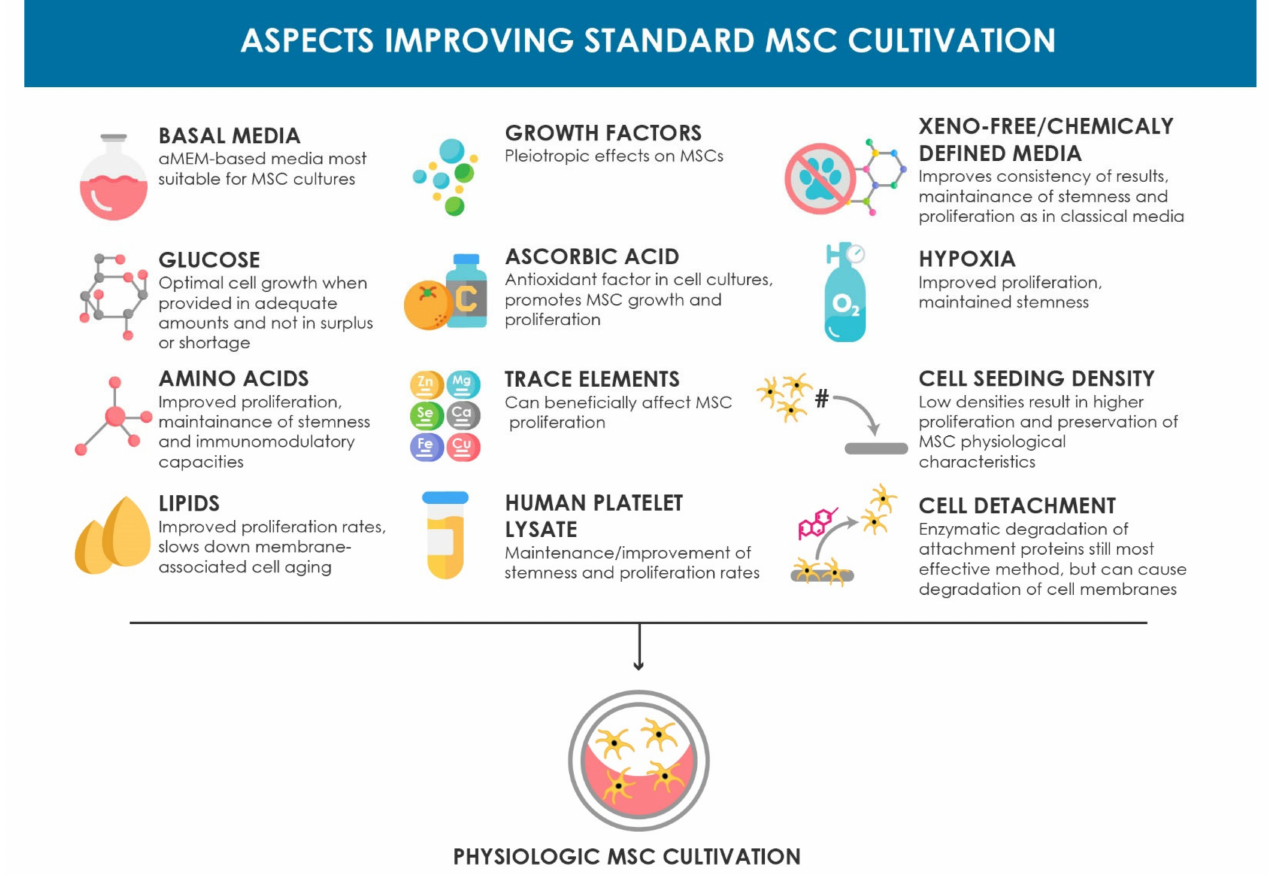
Figure 1. Schematic overview of the aspects improving the standard MSC cultivation setup discussed in this review. The beneficial biological effects are summarized for each